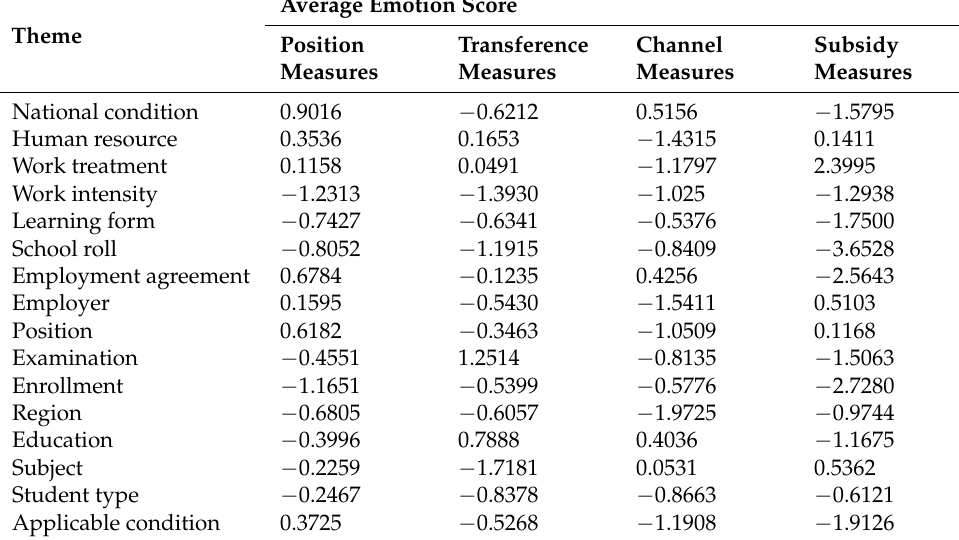
Table 13. Emotion